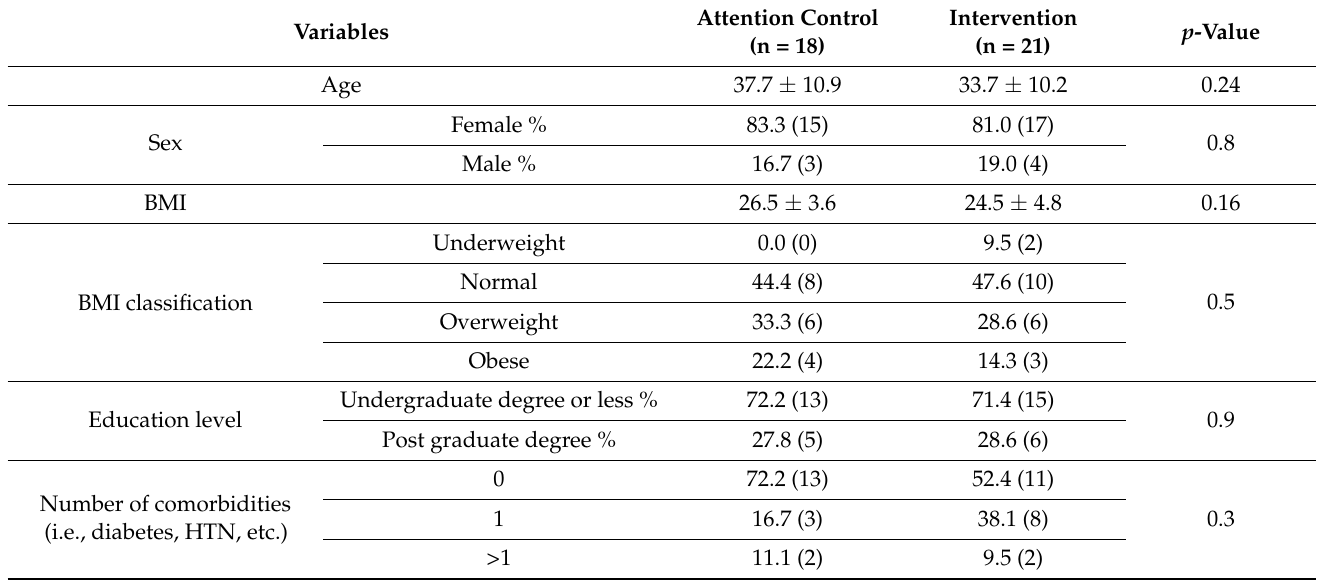
Table 2. Sociodemographic data at baseline. Data compared using chi-square test except for age and BMI where data were compared using student’s t -test. Data reported as mean ± SD or frequency (n).